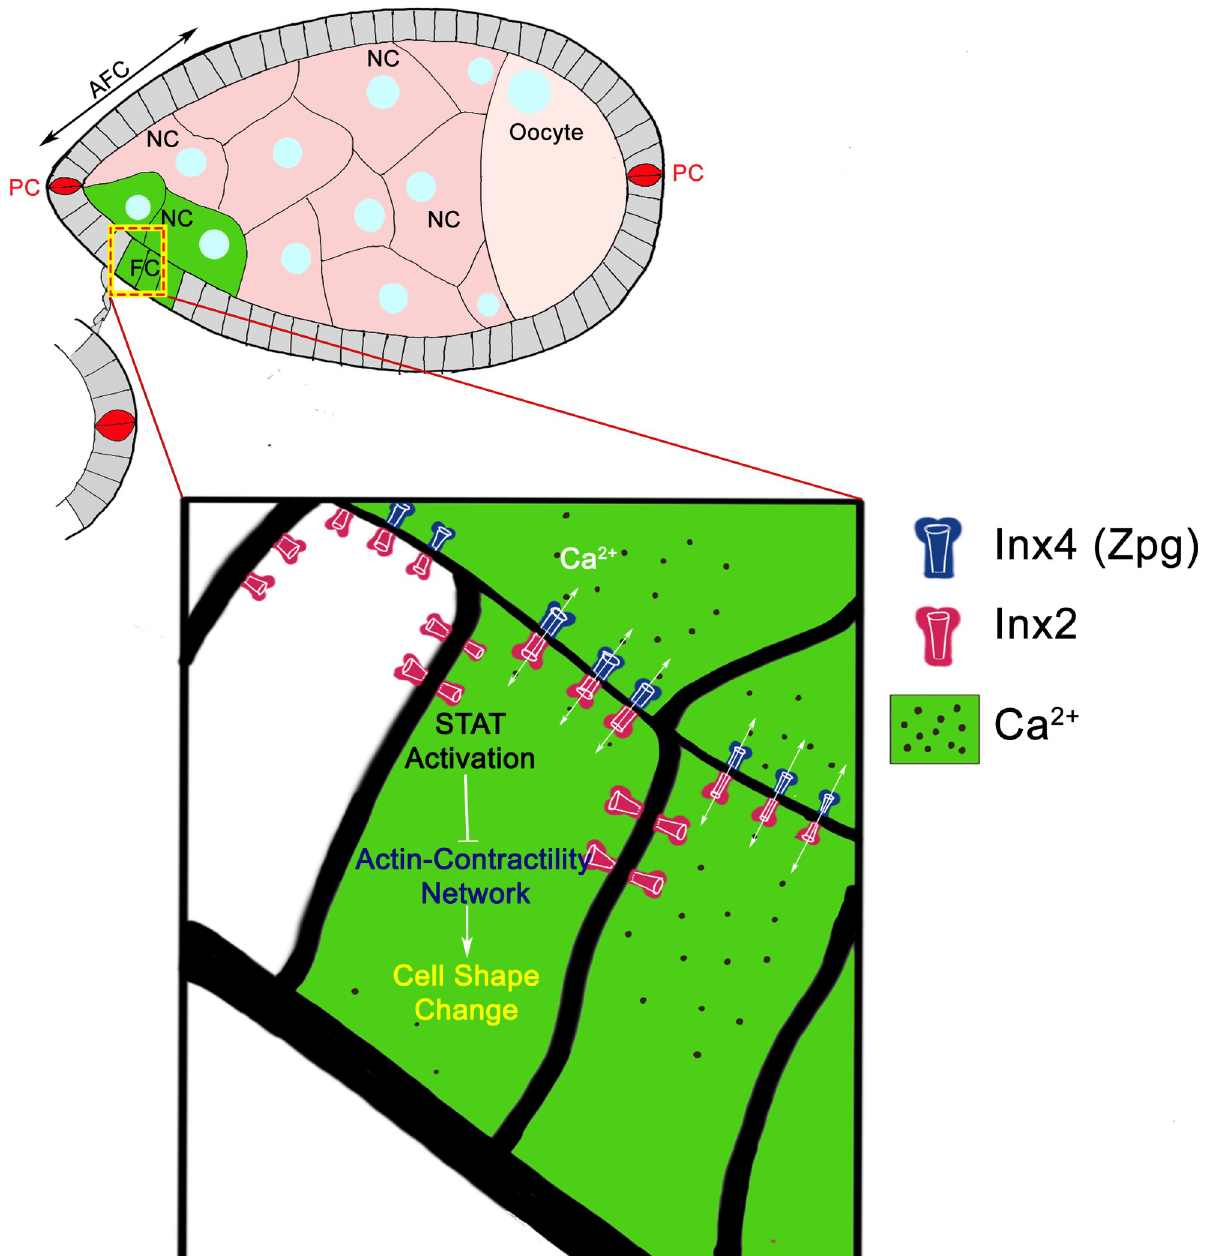
Fig 9. Schematic of the proposed model. Stage 8 egg chambers where abbreviation NC stands for Nurse cells, FC for Follicle cells and PC for Polar cells. The NC and FC shaded in Green indicate the calcium flux. The boxed region of FC in the upper panel is magnified below. Heteromeric GJ channel at the germline (Zpg)/ soma (Inx2) interface stimulate calcium flux in the anterior follicle cells thus activating STAT. Activated STAT negatively regulates the actin contractibility in FC to potentiate cell shape change transition from Cuboidal to Squamous fate.